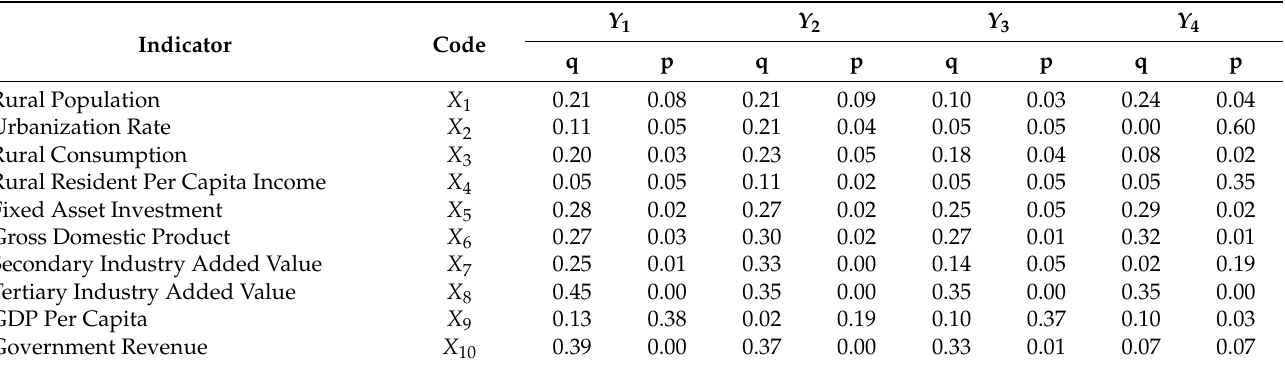
Table 3. Factor detector of village digitalization in Gansu.